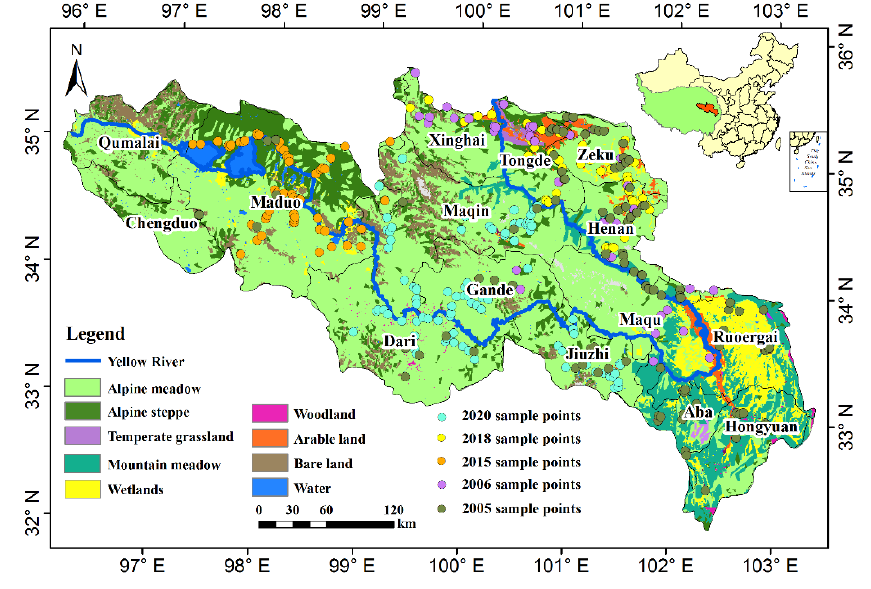
Figure 1. Study area and sample points.